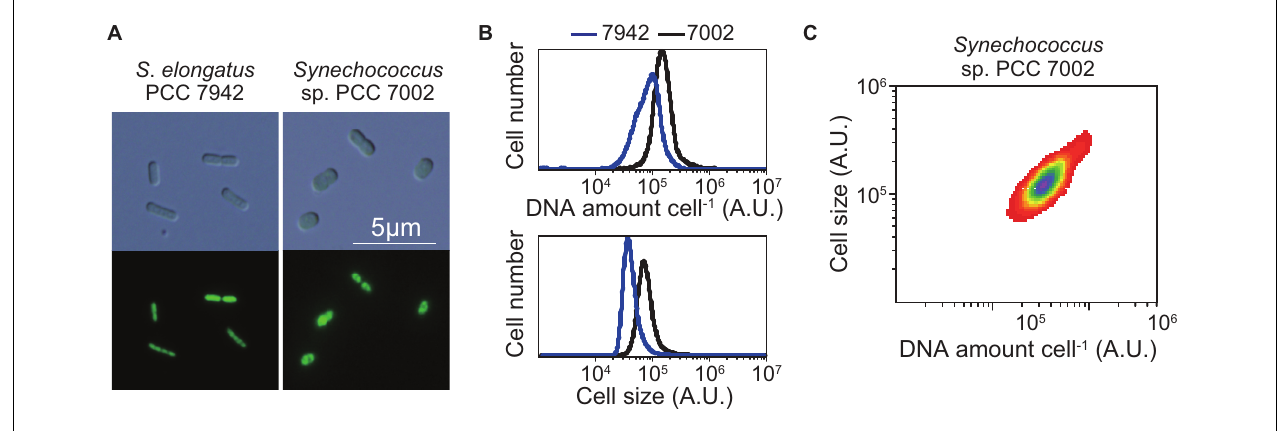
FIGURE 3 | Ploidy of the chromosome of Synechococcus sp. PCC 7002. Exponentially growing Synechococcus sp. PCC 7002 (chromosome, approximately 3.0 Mbp) and for comparison, S. elongatus (chromosome, approximately 2.7 Mbp; 3–6 copies per cell; Zheng and O’Shea, 2017) ( Supplementary Figure S2 ) were fixed and stained with SYBR Green and then examined using flow cytometry. (A) SYBR Green-stained cells. Images were acquired using differential interference contrast microscopy (top) and fluorescence microscopy (bottom). (B) Distribution of the DNA levels per cell and cell volumes of exponentially growing cultures of Synechococcus sp. PCC 7002 (black) and S . elongatus (blue). (C) The relationship between the DNA level and size of Synechococcus sp. PCC